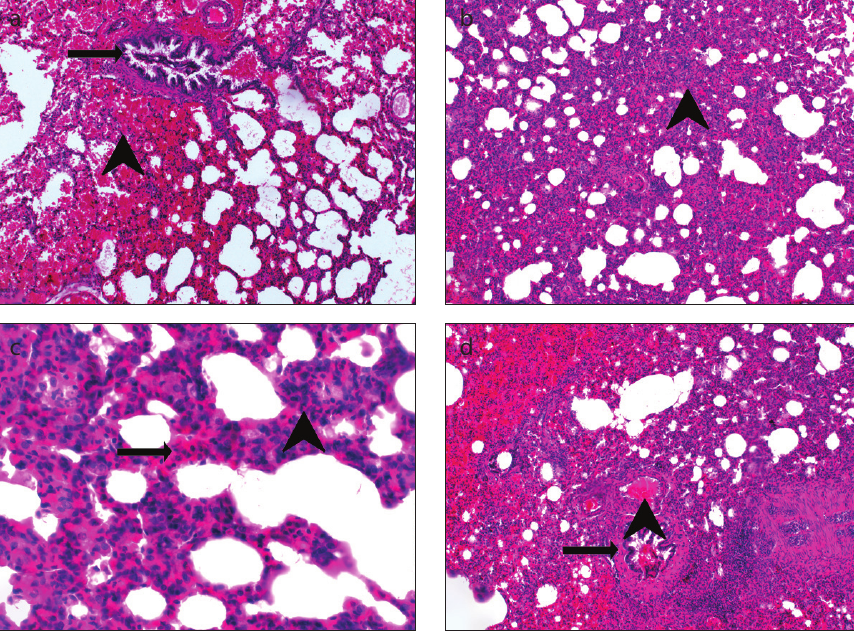
Figure 2. a-d. Appearance of a lung with ARDS: (a) hemorrhage (arrowhead), terminal bronchiole (arrow) (H&E, ×100); (b) thickening of the interalveolar septa (arrowhead), alveolar filling defects (H&E, ×100); (c) PNL infiltration (arrowhead), MNL infiltration (arrow) (H&E, ×200); (d) vasodilation–congestion (arrowhead), terminal bronchiole (arrow) (H&E,